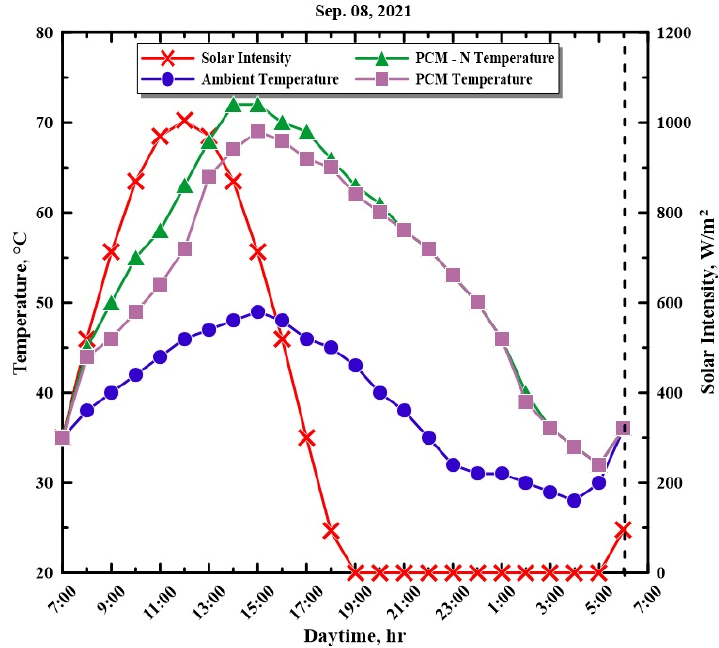
Figure 6. Variations in the temperature of the water, PCM, NPCM, ambient temperature, and solar radiation during the experiment.